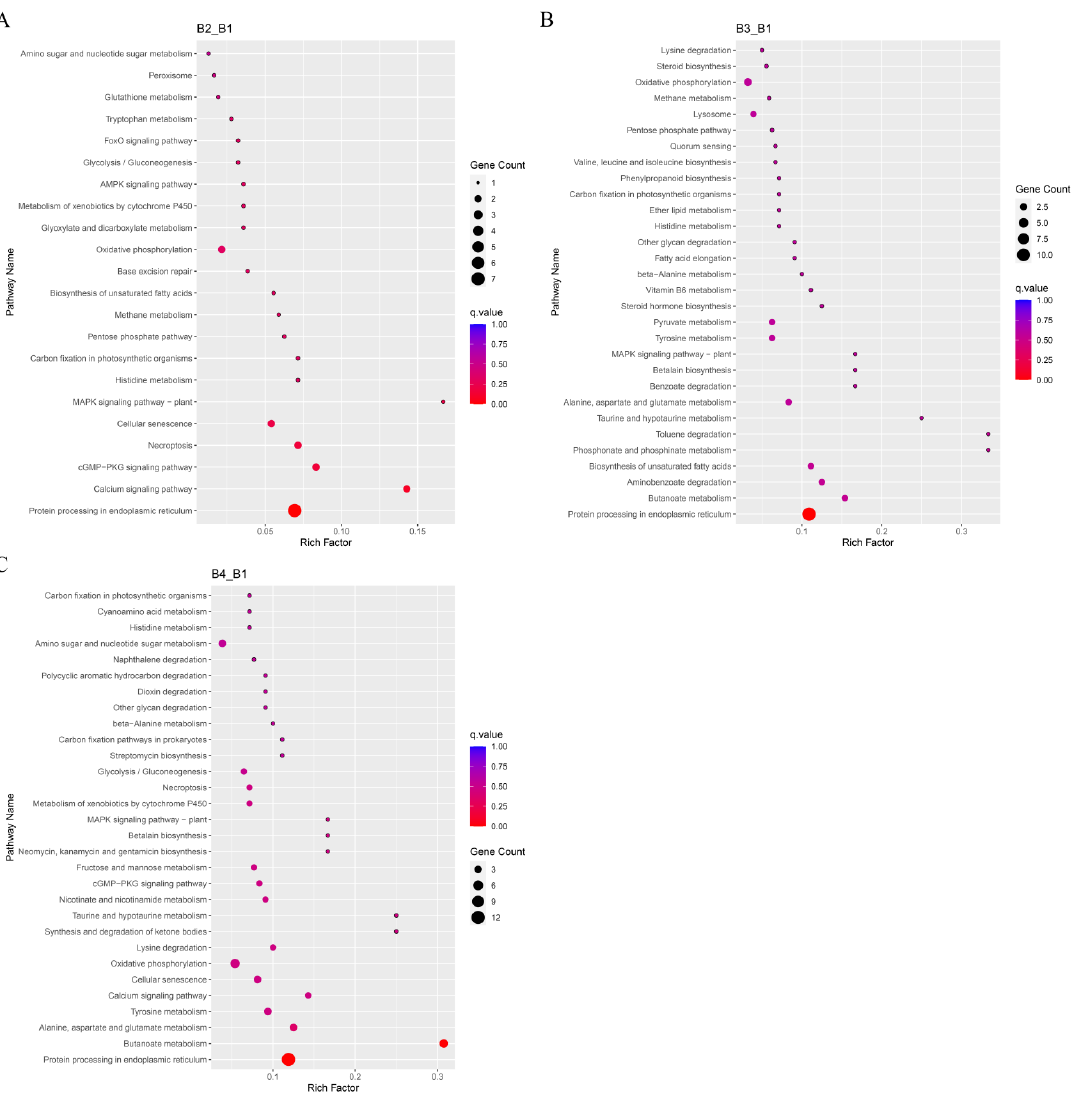
Figure 8. KEGG functional annotation map of significantly up-regulated differentially expressed genes (DEGs). ( A ) Enriched KEGG pathways in DEGs between B2 and B1 (B2_B1). ( B ) Enriched KEGG pathways in DEGs between B3 and B1 (B3_B1). ( C ) Enriched KEGG pathways in DEGs between B4 and B1 (B4_B1).